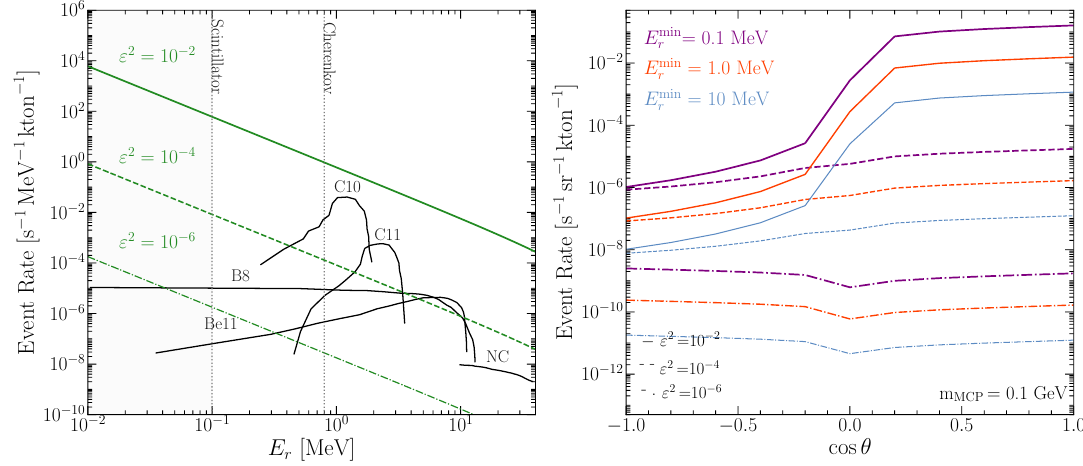
Figure 5 . MCP event rate angular and energy distributions as well as relevant backgrounds for neutrino detectors. Left: expected event rate as a function of the electron recoil energy for MCPs coming in all directions. The vertical dotted lines indicate the different thresholds for scintillator and Cherenkov detectors. The solid black lines indicate the background expected in JUNO from different components (see background section for details). Right: expected event rate as a function of the incoming direction of the MCPs. Solid, dashed, and dot-dashed lines correspond to different values of ε 2 as depicted in the legend. The colors indicate the three different minimum electron recoil energies with values shown in the legend. Both figures are shown for an incident millicharged particle with a mass of 100 MeV